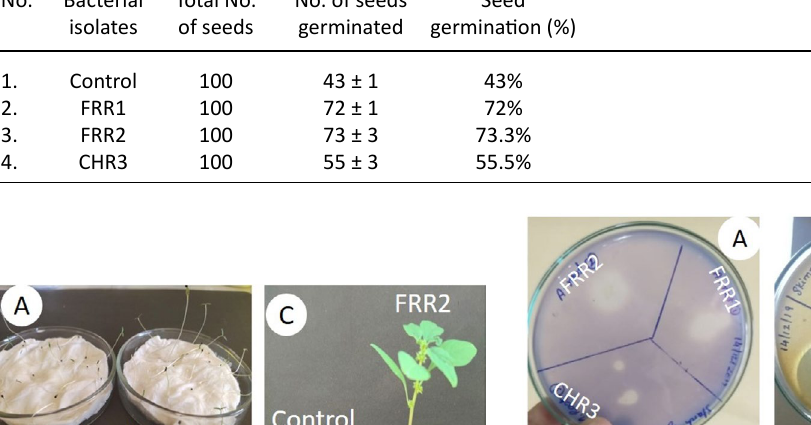
table 1. Effect of endophytes on A. campestris L seed germination. The experiment was repeated three times No.